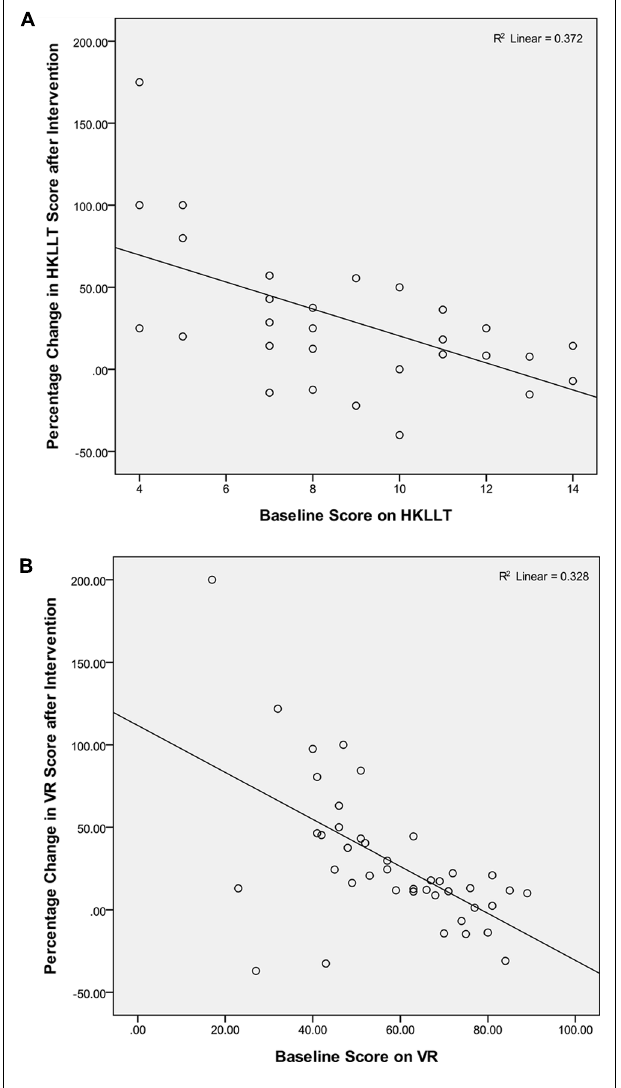
FIGURE 2 |Association between baseline level of performance on (A) verbal and (B) visual memory tests and the percentage change in test performance after